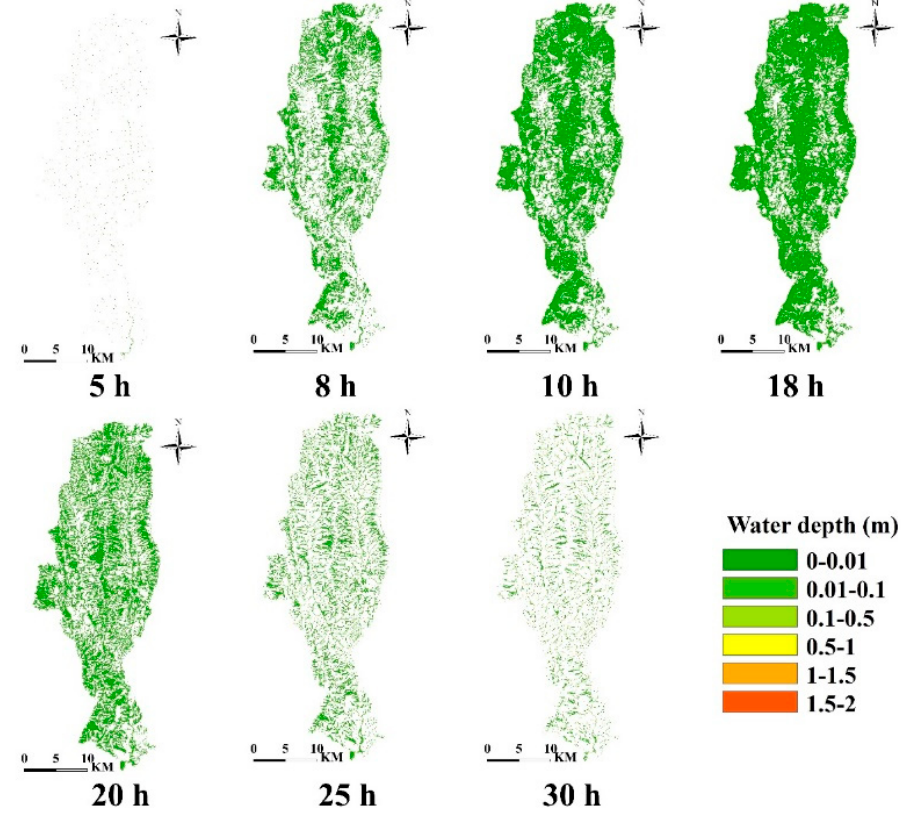
Figure 8. Flood evolution process of flood event 20060706 (only showing some key moments). Based on the flood evolution process, the changes in the flood inundation areas and average water depth were calculated and are presented in Figure 9. Both of them gradually increased over time (Figure 9); at 20 h (near maximum cumulative rainfall), flood inundation areas reached their peak, accounting for 1.3% and reaching 8.45 km 2 . As can be seen in the inundation extent information shown in Figure 8, the roads close to the river (as well as cultivated and urban land) contributed the most to the inundation areas. The results indicate that these risk loci were prone to flooding during significantly heavy rainfall. After 20 h, the spatial distribution of flooded areas was basically stable, indicating that the duration was long and the damage area was relatively